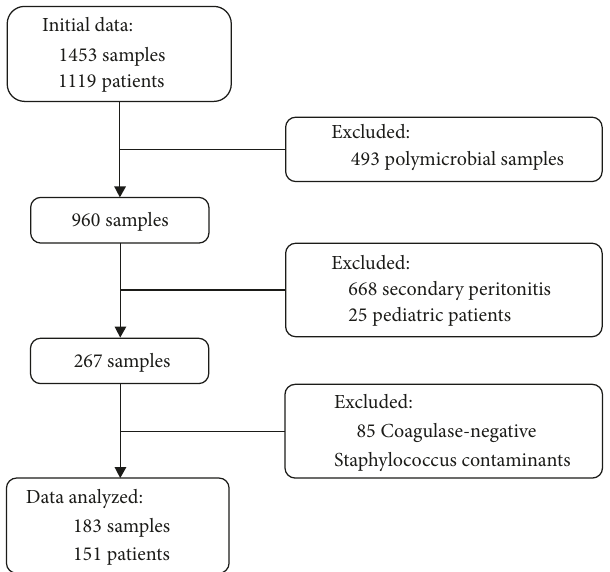
Figure 1: Flowchart of samples and